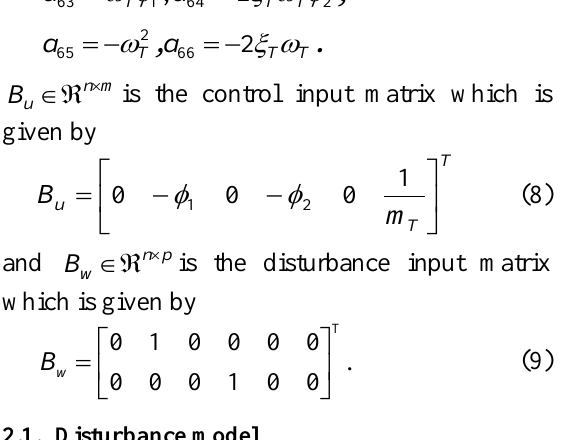
Figure 1. A simplified offshore steel jacket platform having ATMD